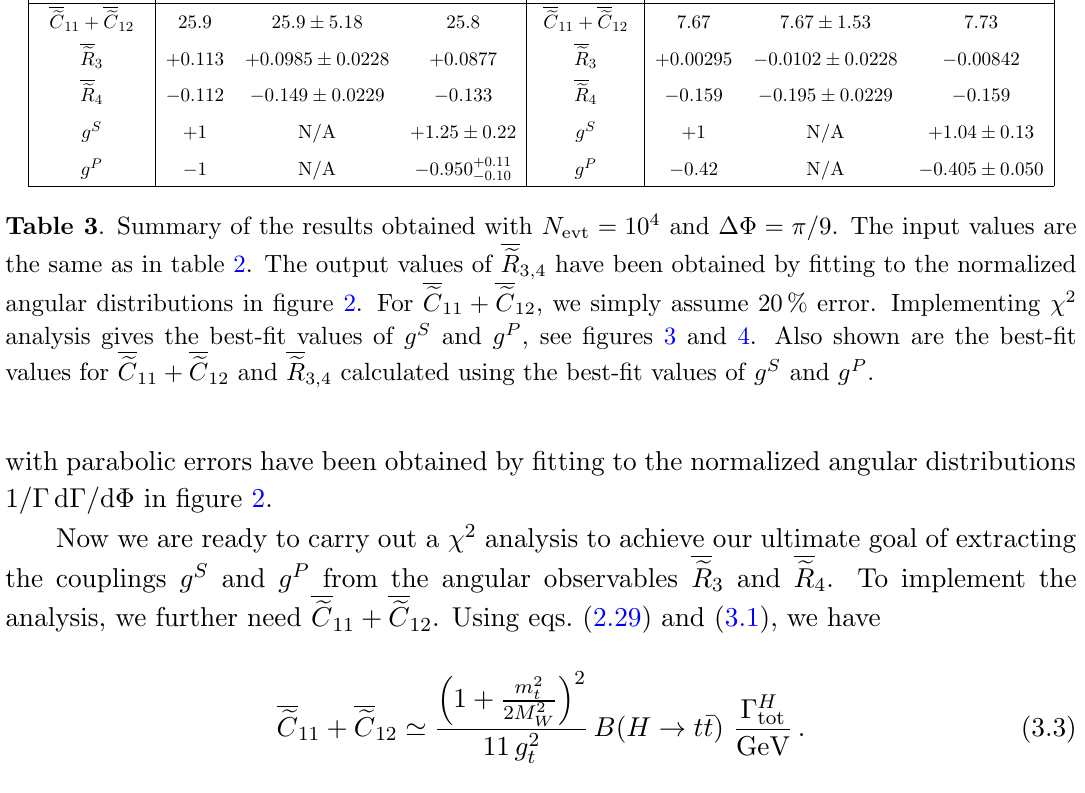
with parabolic errors have been obtained by (cid:12)tting to the normalized angular distributions 1 = (cid:0) d(cid:0) = d(cid:8) in (cid:12)gure